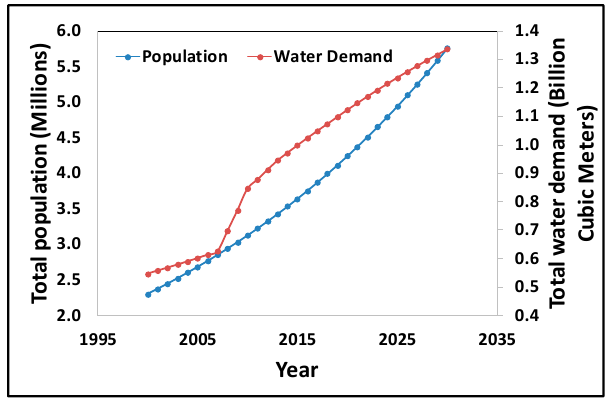
Figure 9. The simulation result for total water demand in the study area.